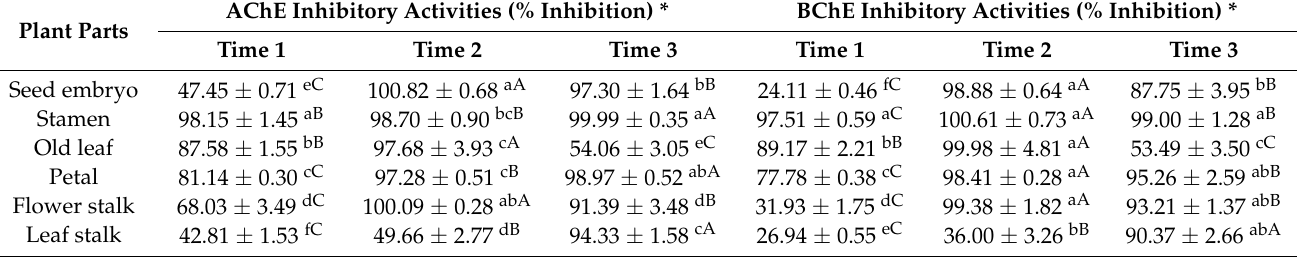
Table 6. Acetylcholinesterase (AChE) and butyrylcholinesterase (BChE) inhibitory activities of different sacred lotus parts collected from different time